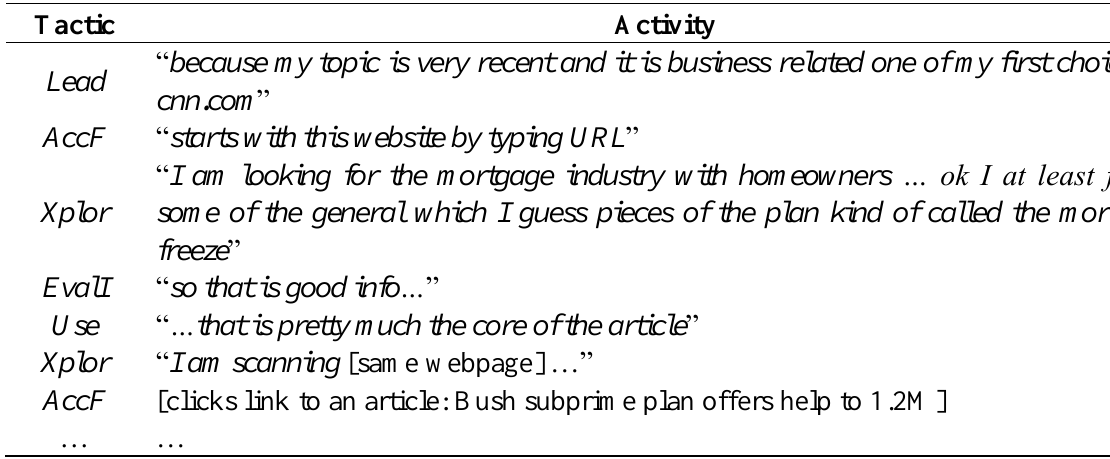
Table 12 . Known-item initiation